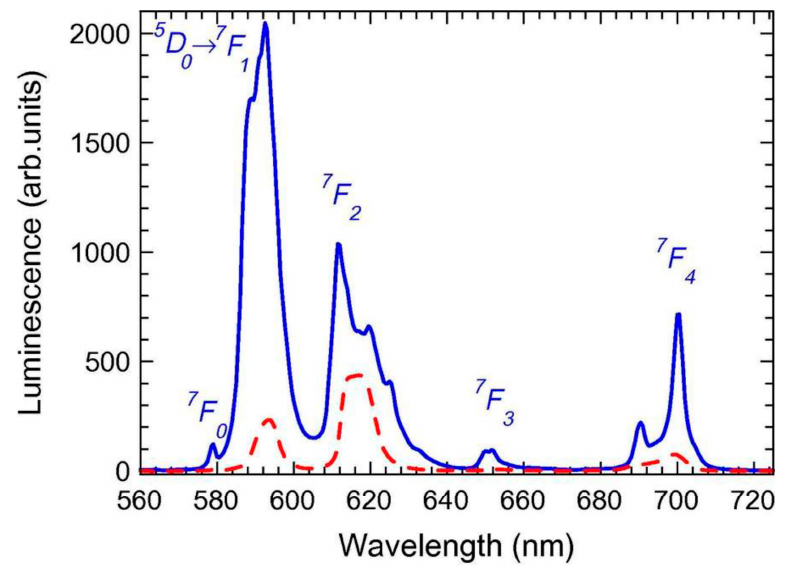
Figure 2. PL spectra recorded on Eu 3+ -doped xerogel (dotted curve) and GC (solid curve) using λ ex. = 394 nm [35].